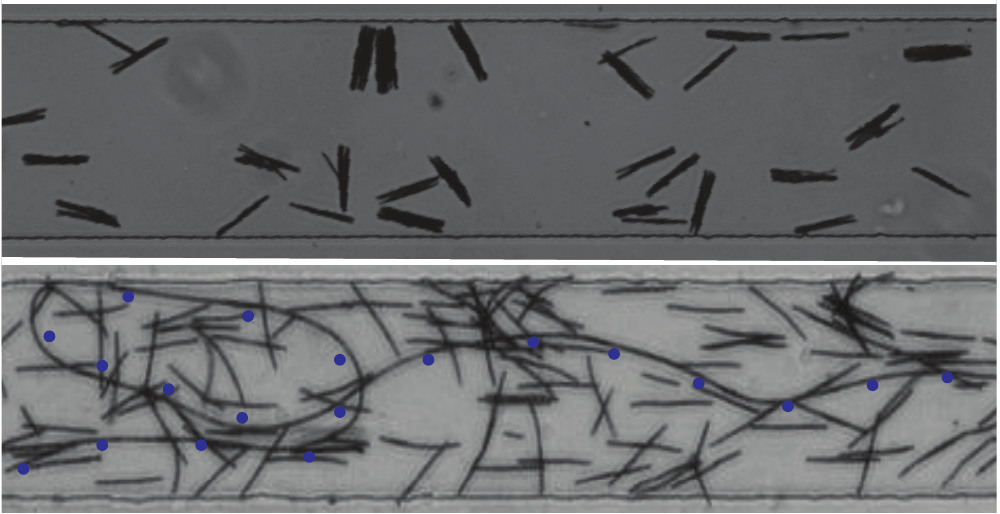
Figure 10. The top picture shows fibers formed by several chains of colloids bridged